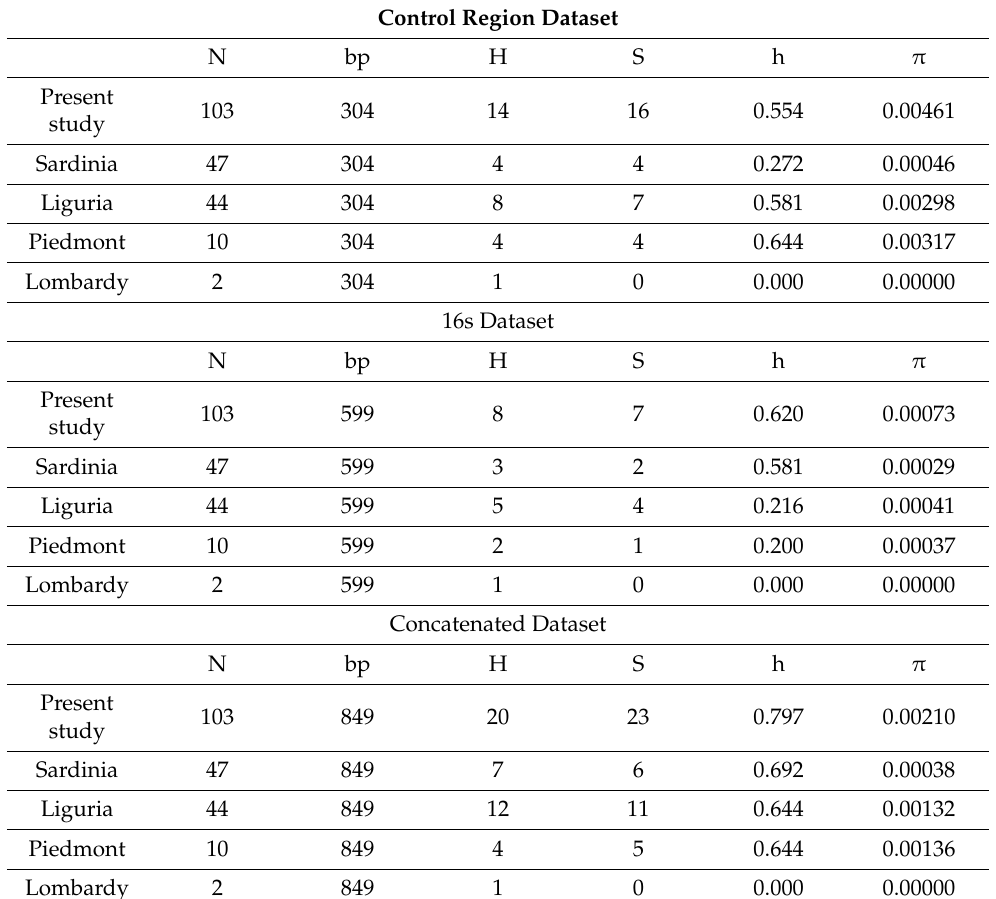
Table 1. Indices of genetic variation. The table reports the estimates of genetic variation for the mitochondrial datasets analyzed in the present study. N: sample sizes; bp: fragment size; S: number of polymorphic sites; H: number of haplotypes; h: haplotype diversity; π : nucleotide